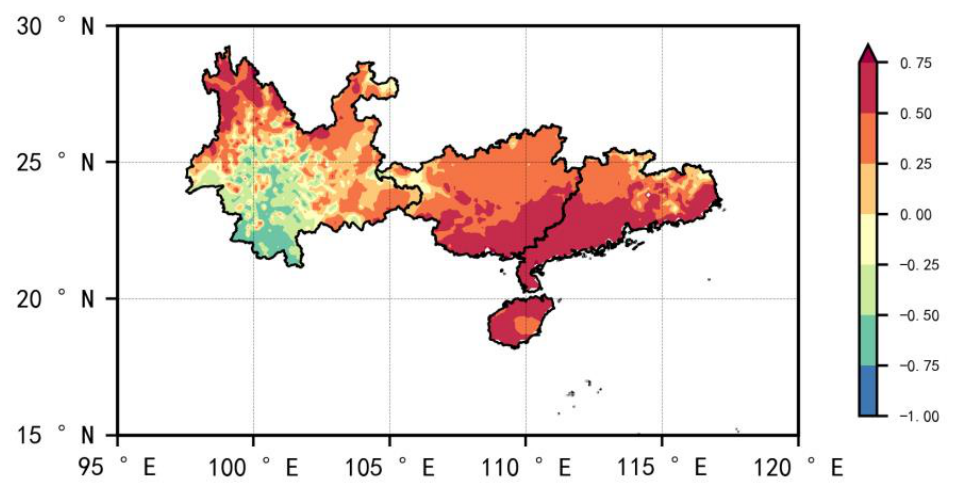
Figure 12. Pearson correlation of the AWD and the SWDI in the subsurface of the four southern provinces of China.